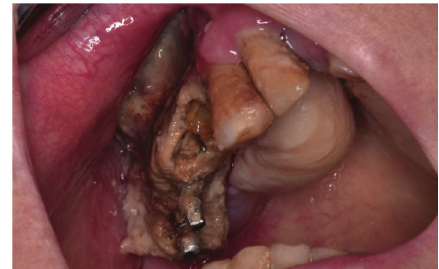
Figure 1: Patient’s preoperative clinical condition: necrotic bone exposure and purulent exudate in quadrant I.